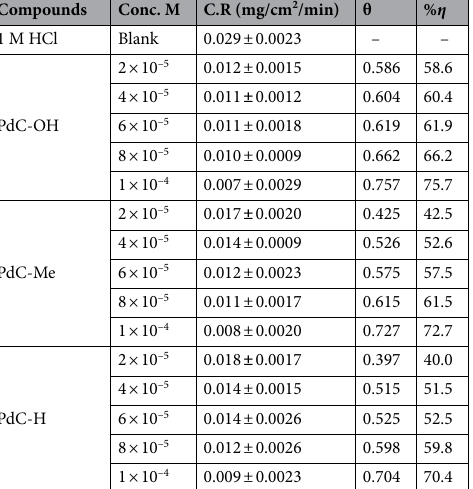
Table 3. Data of Wt. loss method for corrosion of carbon steel in 1 M HCl solution with and without various concentrations of PdC-OH, PdC-Me and PdC-H compounds at 25 °C ± 0.1.